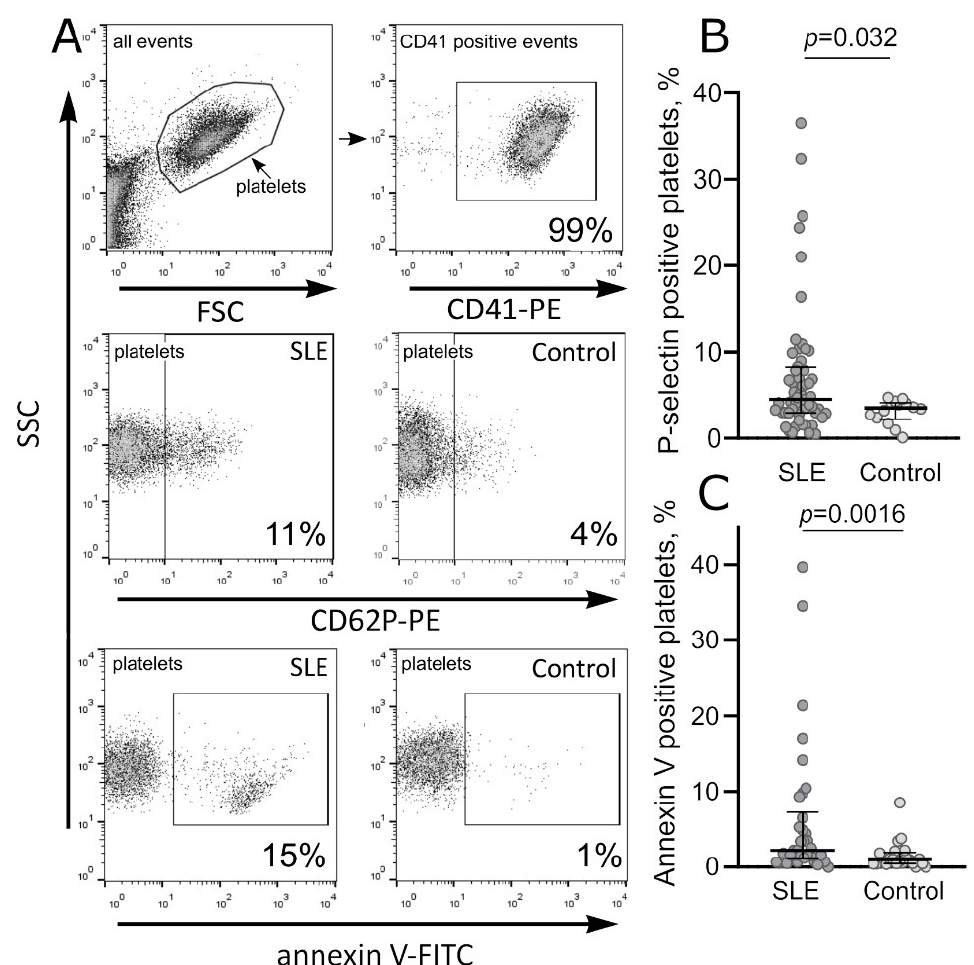
Figure 1. Flow-cytometry-based gating and quantification of platelets expressing P-selectin and phosphatidylserine. ( A ) Upper row : Representative dot-plots of platelets from the blood plasma showing the platelet gating strategy based on the forward (FSC) and side (SSC) scatter values (left) and verified using a platelet specific marker CD41 (right). Middle row : Representative dot-plots demonstrating the fractions of in vitro unstimulated CD62p-PE-positive platelets (expressing P-selectin) in the blood of an SLE patient (left) and a healthy donor (control). Bottom row : Representative dot plots showing the fractions of in vitro unstimulated annexin V-FITC-positive platelets (expressing phosphatidylserines) in the blood of an SLE patient (left) and a healthy donor (control). ( B ) Fractions of unstimulated platelets expressing P-selectin (CD62p) on the surface in the SLE patients ( n = 56, dark grey dots) and healthy donors (control, n = 14, light grey dots) based on the gating strategy shown in A. ( C ) Fractions of unstimulated platelets expressing phosphatidylserine in the SLE patients ( n = 34, dark grey dots) and healthy donors (control, n = 22, light grey dots) based on the gating strategy shown in A. The data in ( B , C ) are presented as a median with IQR and analyzed with a Mann–Whitney test. Unstimulated platelets from the blood of SLE patients also had a significantly larger fraction of P-selectin-positive platelets than platelets from the healthy donors (Table 1a, Figure 1A,B). Specifically, the fraction of P-selectin-positive platelets in the SLE patients ranged from 0.5% to 36.5%, while in the platelet preparations from healthy subjects, the range was 0.1–4.7% ( p = 0.032). The group of SLE patients had an increased average level of sP-selectin in plasma (51 ± 18 ng/mL) compared with the normal values (34 ± 5 ng/mL, p < 0.001) as also reported by [14] (Table 1b). The hyper-production of P-selectin likewise indicates moderate continuous background platelet activation in